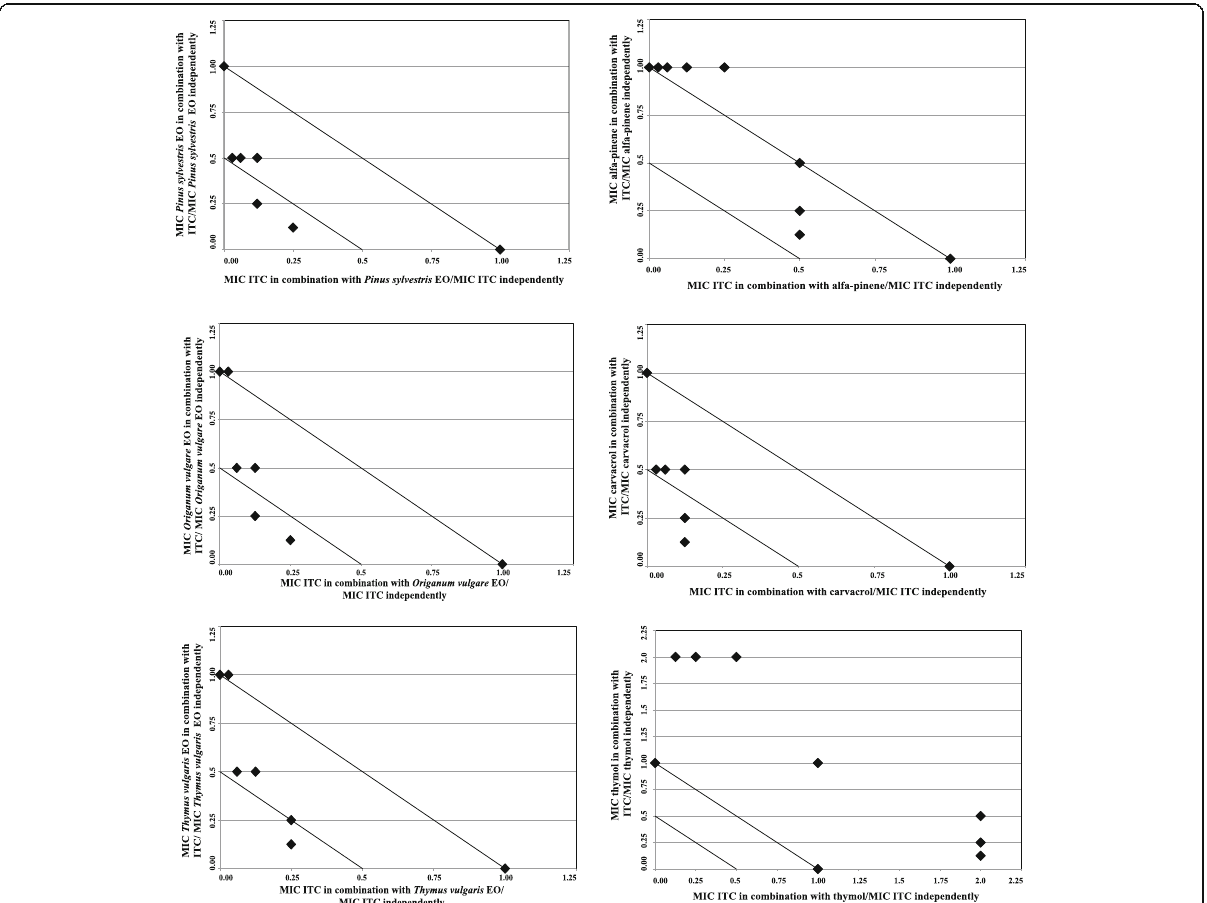
Fig. 1 Isobologram plots of ITC and EOs/EO main components against C.neoformans ADS 37 (azole-susceptible strain). Points along the isobolograms represent the growth no-growth interface: fractional inhibitory concentration (FIC) values of ITC are plotted on x -axis, and FIC values of EOs/EO main components are plotted on y